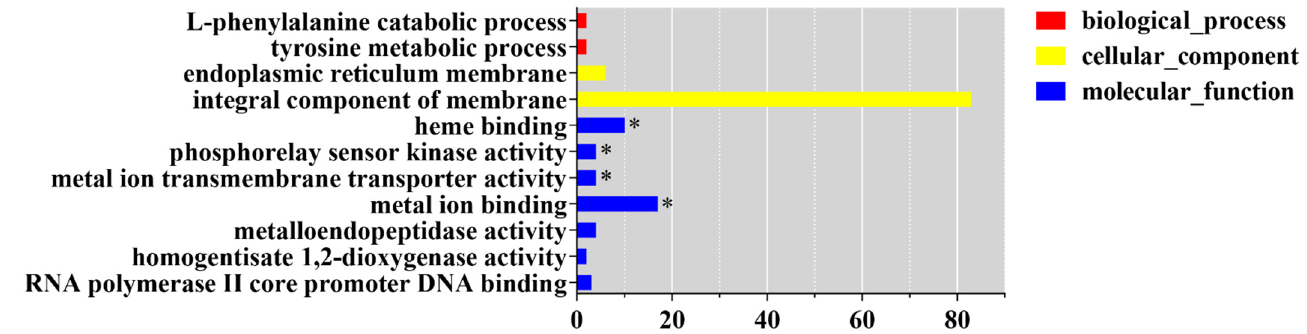
Figure 8. GO functional classification of CmWC-1 target genes identified by ChIP-seq. * Indicates significantly enriched GO terms (FDR < 0.05).